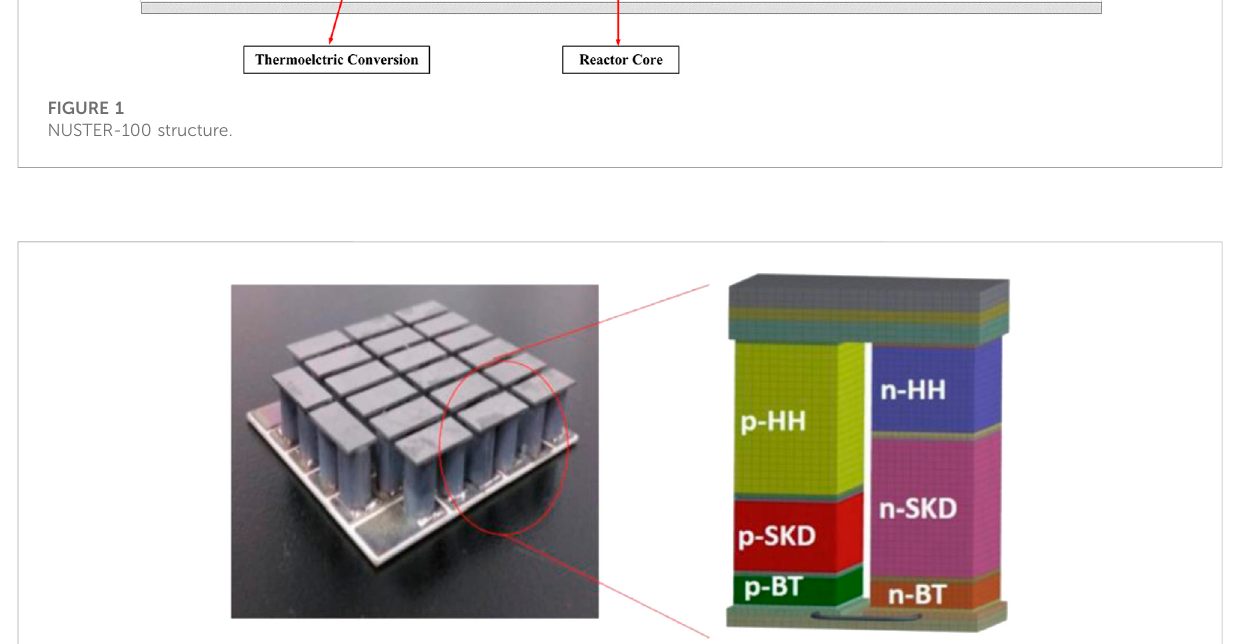
Thermoelectric converter schematic (Tang et al.,